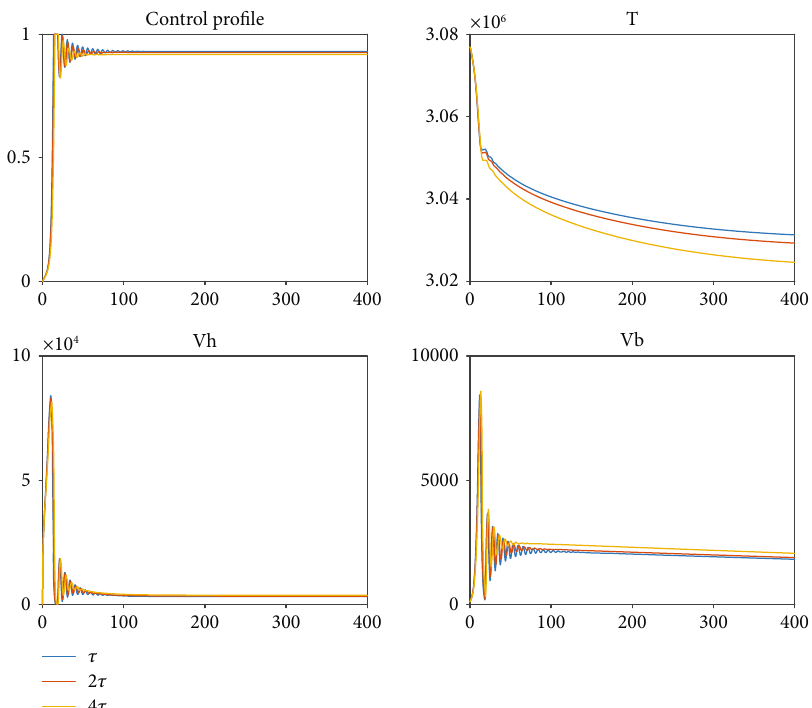
Figure 8: Healthy hepatocytes, control pro fi les, HIV copies, and HBV copies with varying intracellular delay periods. Parameter values are as shown in Table 1. Horizontal axes represent time in